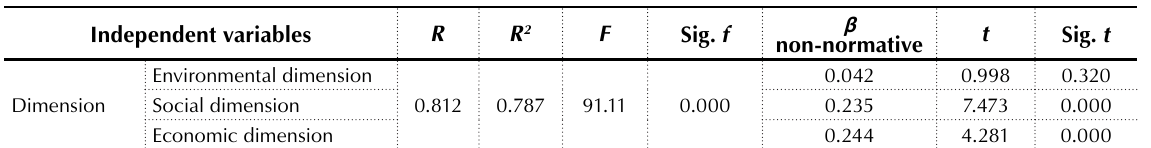
Table 5. Results of the first sub-hypothesis